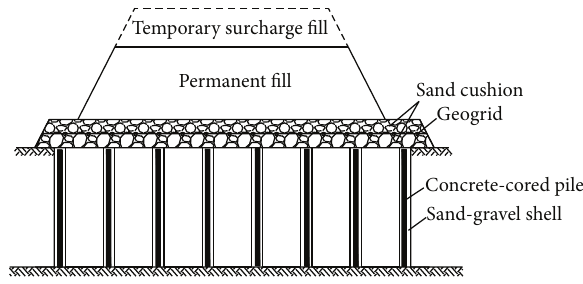
Figure 1: Schematic diagram of section.